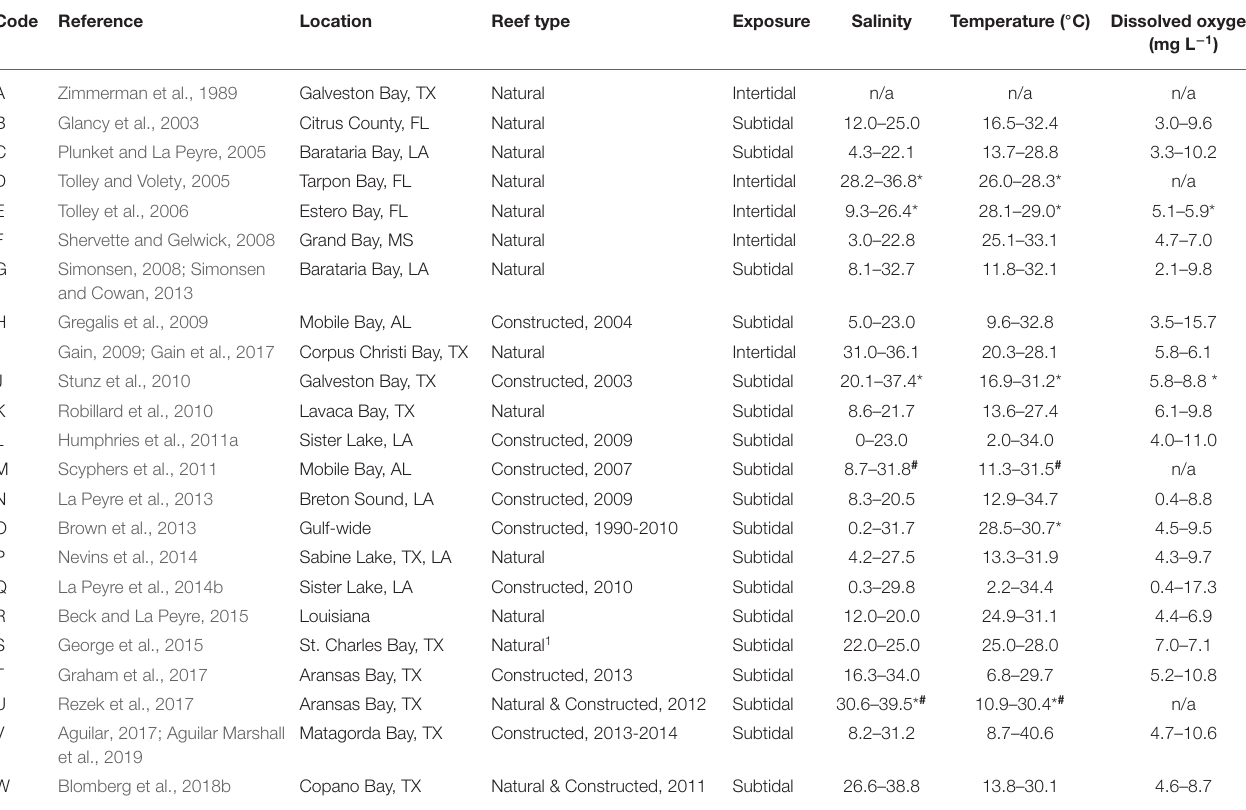
TABLE 1 | List of studies identified as sampling for nekton assemblages on oyster reefs within estuaries across the northern Gulf of